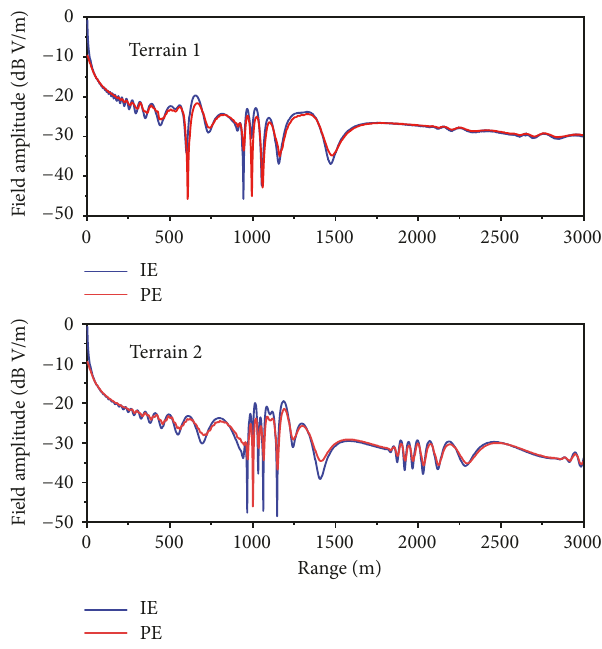
Figure 10: Electric field at a fixed height of 200 m. power transmission lines are marked as red triangles in the map (see Figure 12). The heights of the transmission